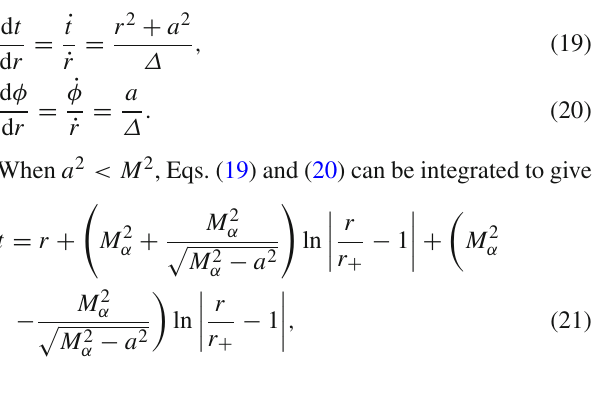
Fig. 2 The trajectory of the photon in the case of the Kerr-MOG black hole with a = 0 . 8 and α = 0 . 5. As a photon approaches the Kerr-MOG black hole, it has a discontinuous orbit at the outer and inner horizons ( r + = 2 . 4274 and r − = 0 . 5726). Consequently, the trajectory of the photon is similar to the Kerr black hole for horizons but the photon is bending rapidly to the ring singularity compared to the Kerr black